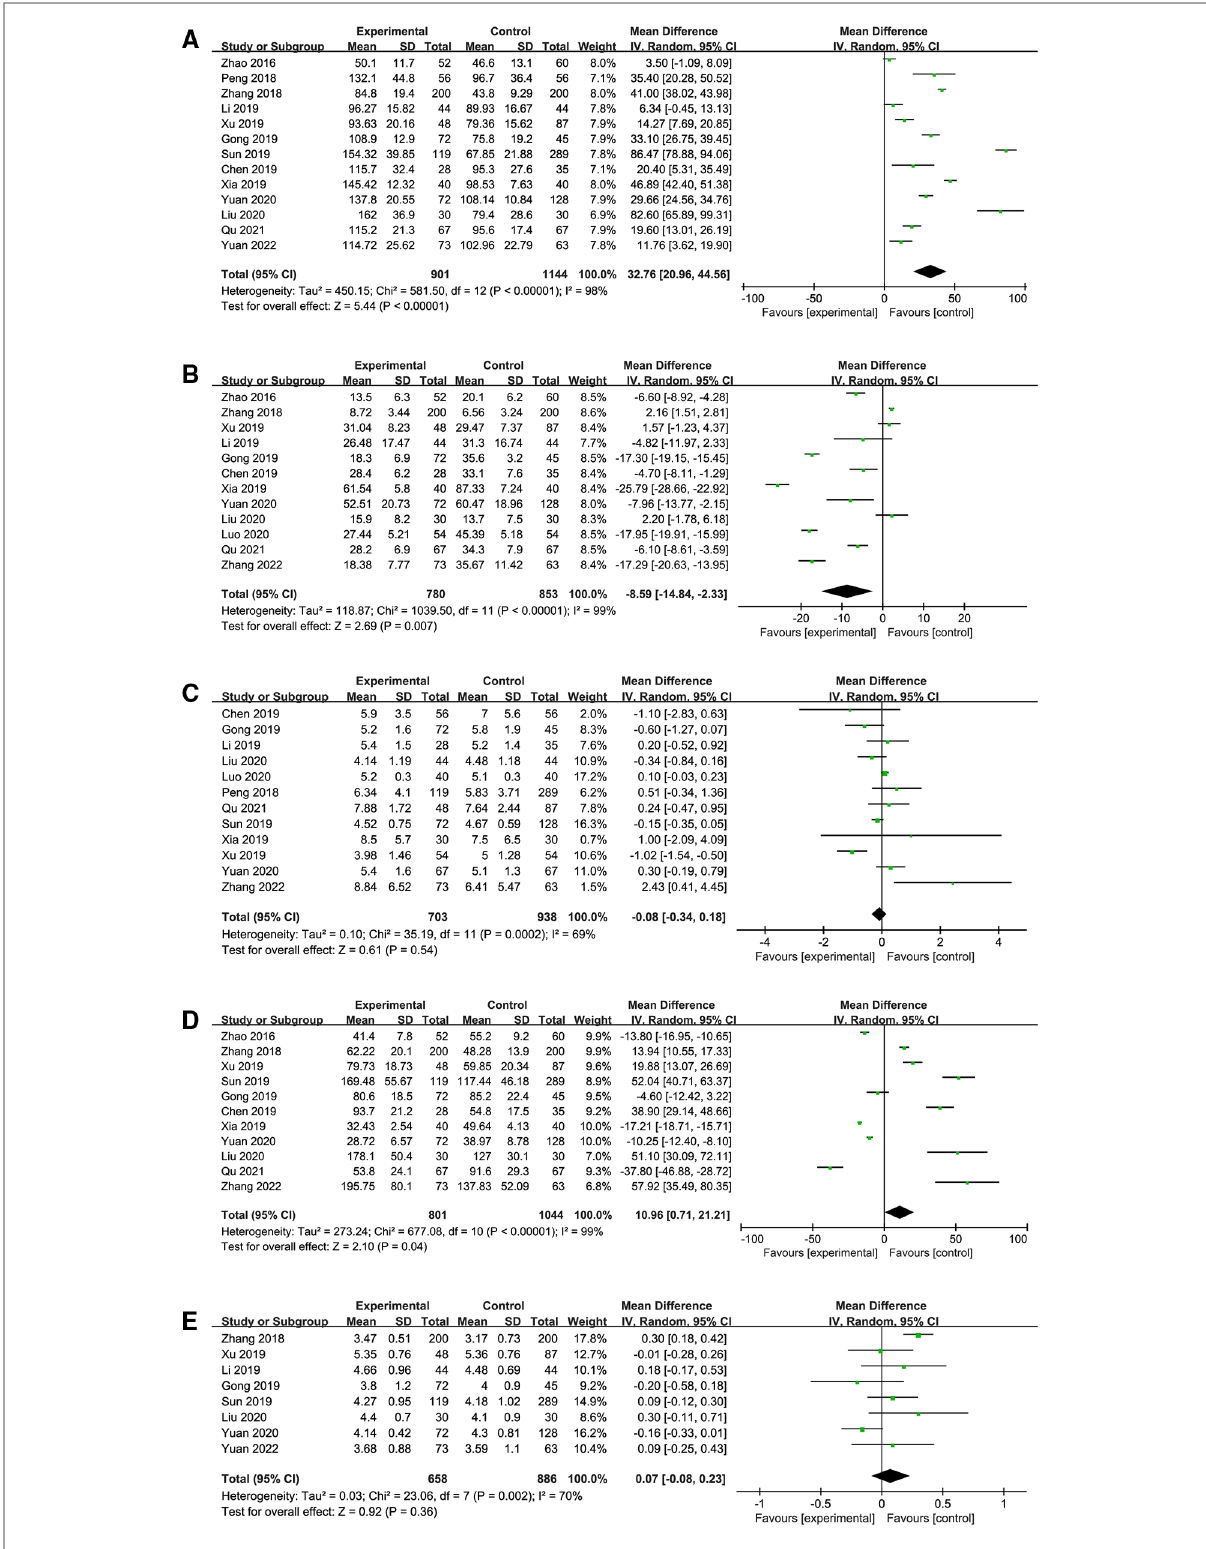
FIGURE 2 Forest plot of the meta-analysis. Experimental group: ETCA group; Control group: COT group. ( A ) operative time; ( B ) intraoperative bleeding volume; ( C ) removed lymph node; ( D ) postoperative drainage volume; ( E ) length of postoperative hospital